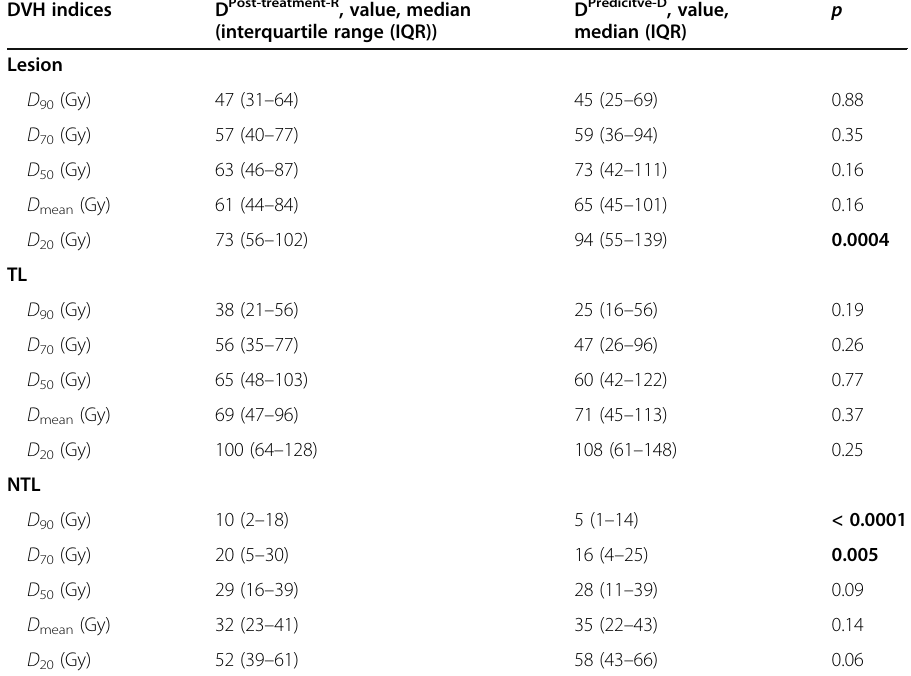
Table 2 DVH indices of D Post-treatment-R and D Predicitve-D for the different VOIs DVH indices D Post-treatment-R , value, median (interquartile range (IQR))